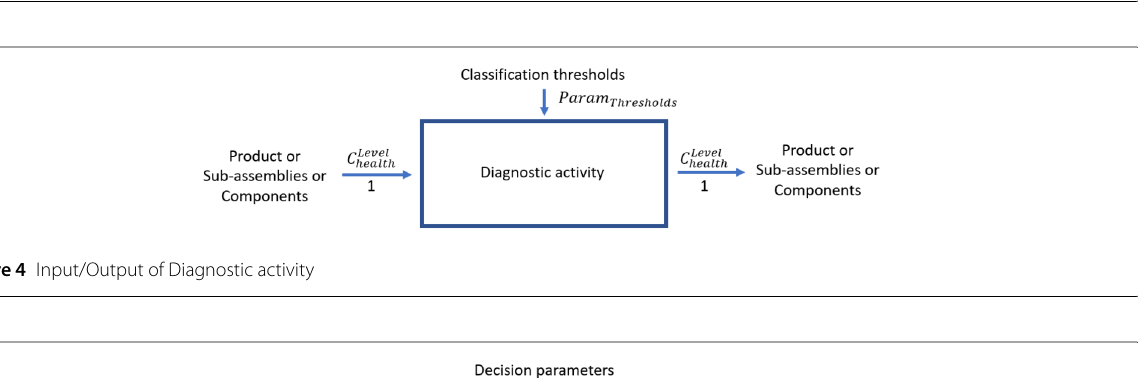
Figure 3 Overview example of a GCSPN